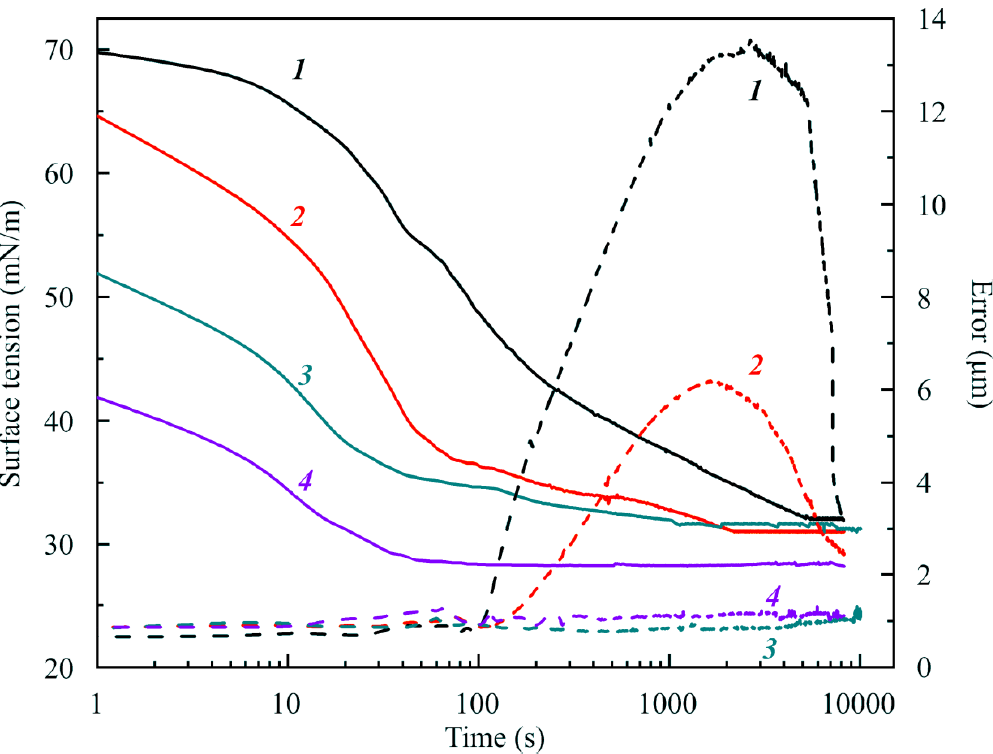
Figure 8. Dependencies of surface tension and Error on time for aqueous C 13 DMPO solutions at different concentrations: 1 , 10; 2 , 20; 3 , 30; and 4 , 50 μmol/L), obtained in experiments with a capillary diameter of 2 mm, initial drop volume 10 mm 3 and surface area 20 mm 2 .